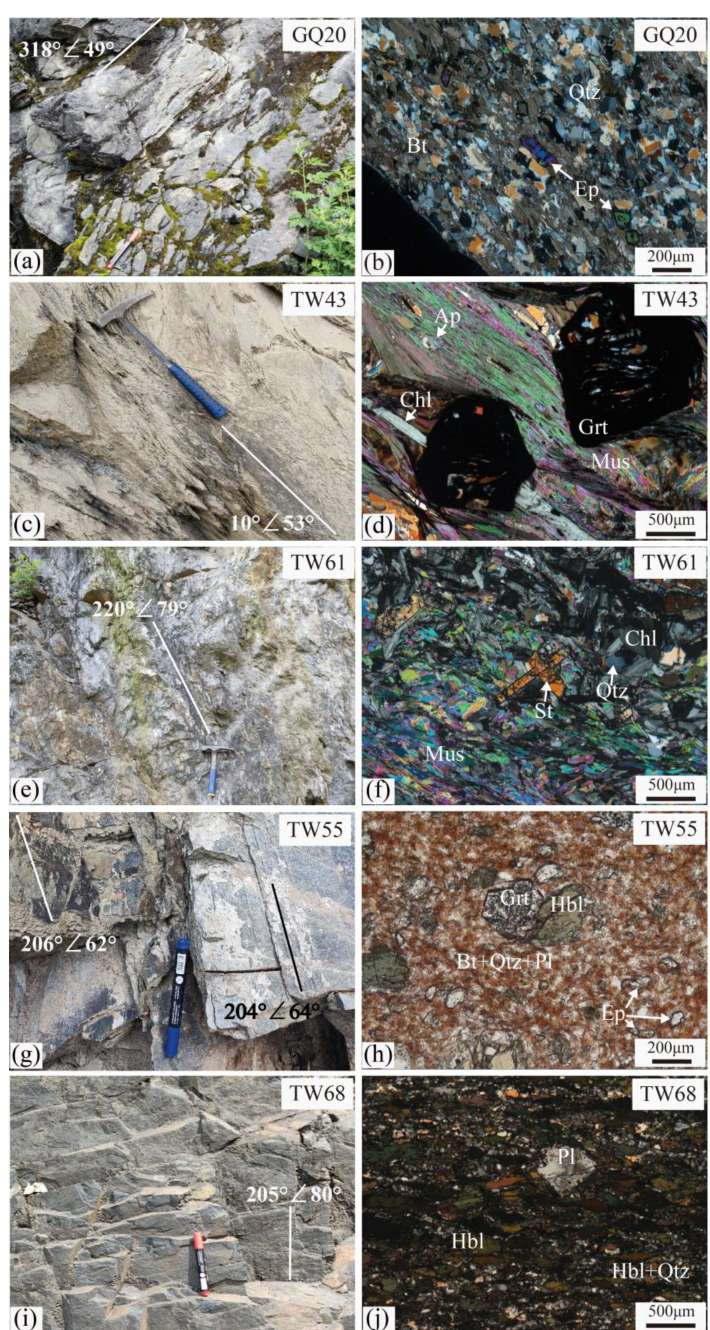
Figure 2. Field photographs and micrographs of studied samples from the Liuling Group and Wuguan Complex. ( a ) Biotite quartz schist (Sample GQ20) from the Liuling Group. ( b ) The mineral assemblage of biotite quartz schist (Sample GQ20), with schistosity defined by biotite. ( c ) Garnet mica quartz schist (Sample TW43) from the Liuling Group. ( d ) The mineral assemblage of the garnet mica quartz schist (Sample TW43). Late muscovite surrounds the early garnet grains, which contain a large number of inclusions. ( e ) Garnet staurolite mica schist (Sample TW61) from the Wuguan Complex. ( f ) The mineral assemblage of garnet staurolite mica schist, with schistosity defined by muscovite. ( g ) Garnet amphibolite (Sample TW55) from the Wuguan Complex. ( h ) Porphyroblasts of the garnet and hornblende within the biotite quartz plagioclase symplectites (Sample TW55). ( i ) Hornblende schist (Sample TW68) from the Wuguan Complex (Sample TW68). ( j ) Hornblende schist (Sample TW68) is dominated by hornblende with referred